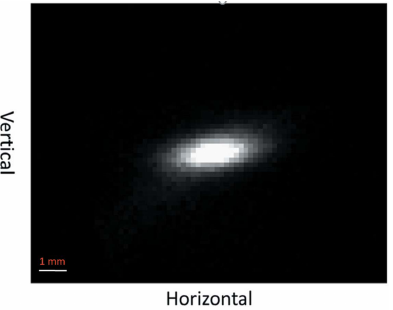
Figure 4 The direct focused photon beam collected on a PILATUS 300K detector at 15